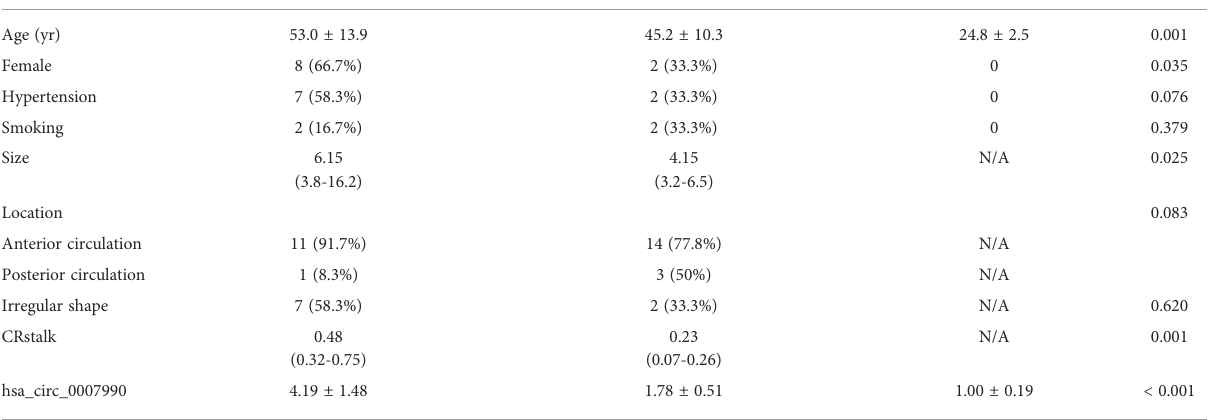
TABLE 1 Clinical characteristics of participants with unruptured intracranial aneurysm and healthy control. UIA patients with AWE (n = 12) UIA patients with non-AWE (n =